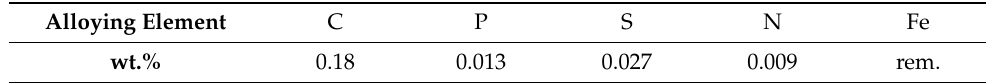
Table 1. Chemical composition of S235JR steel used as the substrate. Alloying